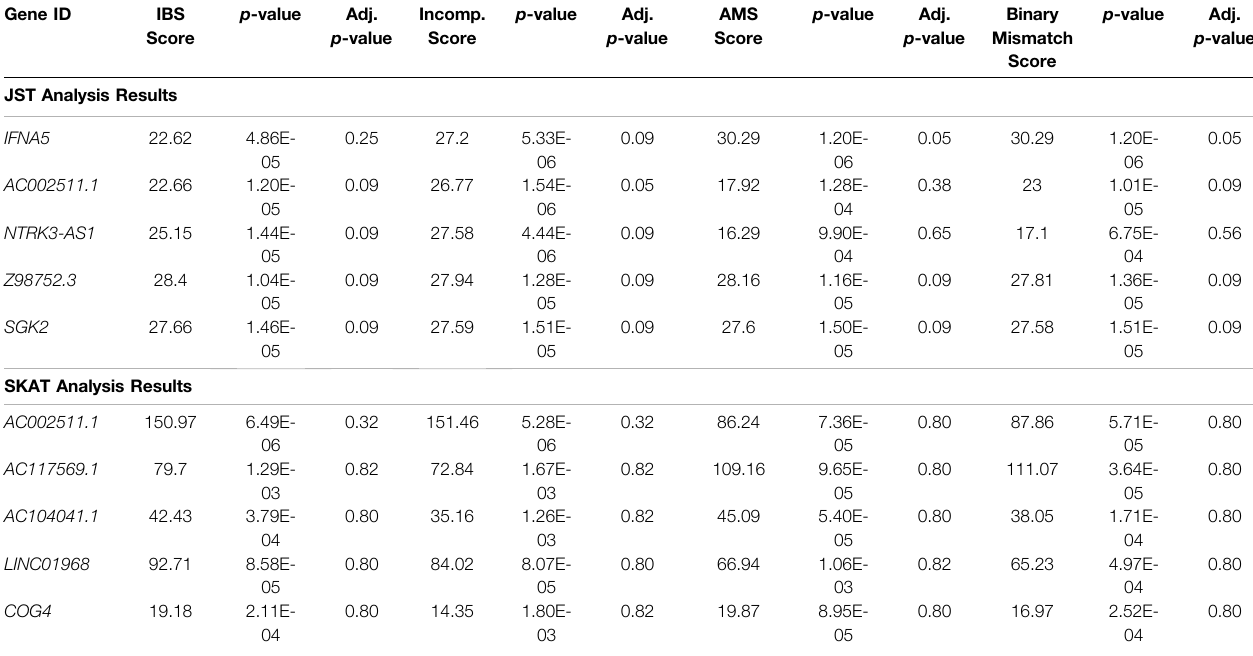
TABLE2| ResultsofJSTandSKATanalysisofcombinedGEN03andDeKAFdatasets.Thetop5genessortedby p -valuefrom fi ttingamodelwiththeanyofthefourgene- based score are shown. JST was calculated using p (cid:2) 85% of variance explained. SKAT was run using the IBS kernel. Adj. p -value: p -value adjusted for multiple comparisons using FDR, IBS: identity-by-state, Incomp: incompatibility, AMS: allogenomics mismatch